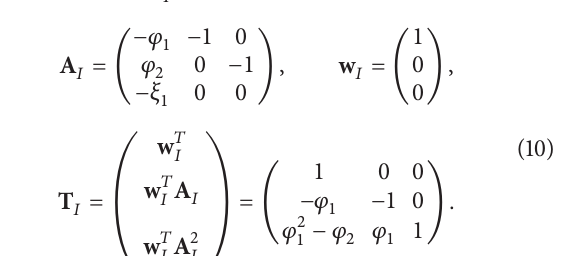
T −1 A T = A 𝑅 𝐽 𝐽